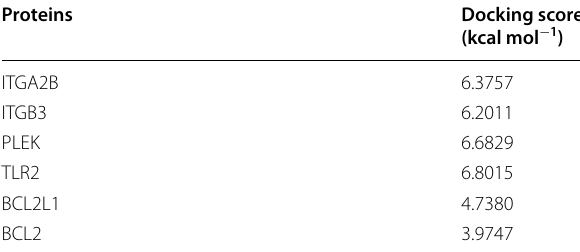
Table 1 Docking score of DMAG with the core proteins